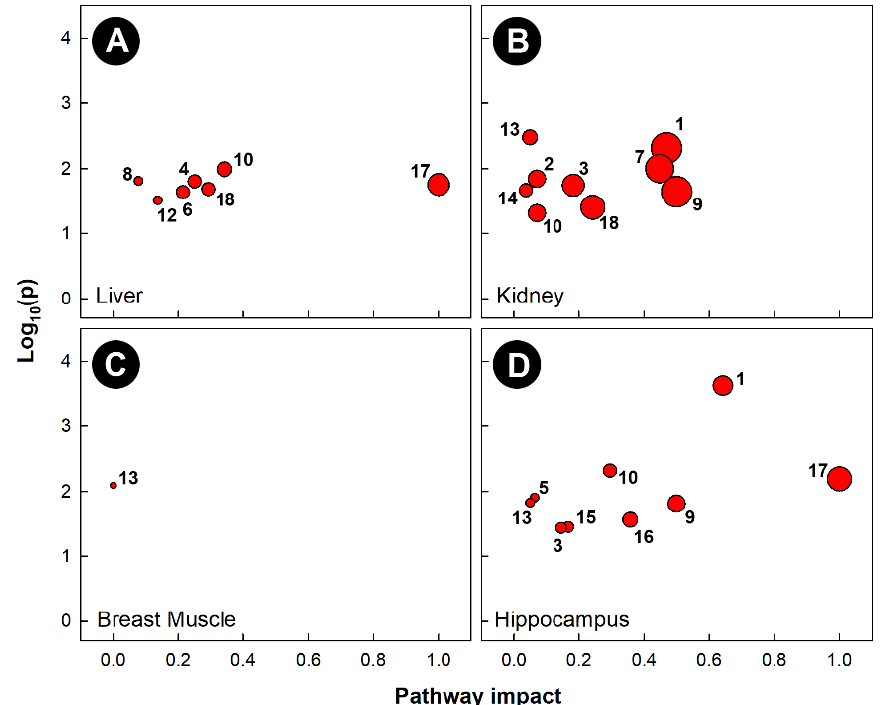
Figure 7. Pathway topologies of tissues from chicks subjected to heat stress. ( A ) Liver; ( B ) kidney; ( C ) breast muscle; and ( D ) hippocampus. Pathways are: 1, alanine, aspartate, and glutamate metabolism; 2, arginine biosynthesis; 3, arginine and proline metabolism; 4, ascorbate and aldarate metab-